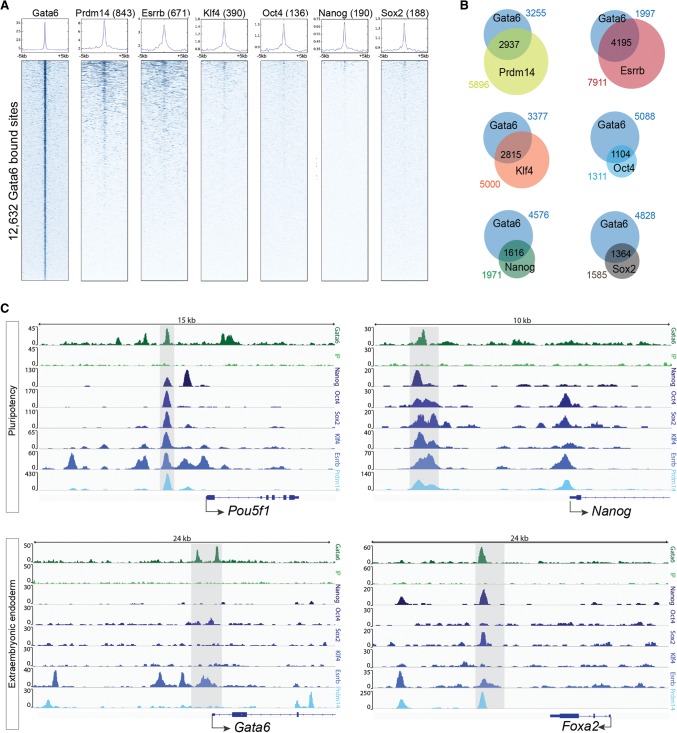
Gata6 binds to loci occupied by pluripotency factors in mES cells. (A) Density heat maps of Gata6-binding peak intensity after 36 h of Gata6 induction, indicating direct overlap with Nanog, Oct4, Sox2, Klf4, Esrrb, or Prdm14 binding in mES cells within a 10-kb window centered at the transcription start site (TSS). Data for Nanog, Oct4, Sox2, Klf4, Esrrb, and Prdm14 were obtained from the Mouse ES Cell ChIP-Seq Compendium (http://bioinformatics.cscr.cam.ac.uk/ES_Cell_ChIP-seq_compendium.html; Martello et al. 2012). (B) Venn diagram indicating the overlap of Gata6-bound genes during reprograming compared with genes previously shown to be bound by Oct4, Sox2, Klf4, Esrrb, or Prdm14 in mES cells. (C) Binding profiles at the Pou5f1, Nanog, Gata6, and Foxa2 loci for Gata6 and the input control during reprograming compared with Nanog, Oct4, Sox2, Klf4, Esrrb, or Prdm14 in mES cells.